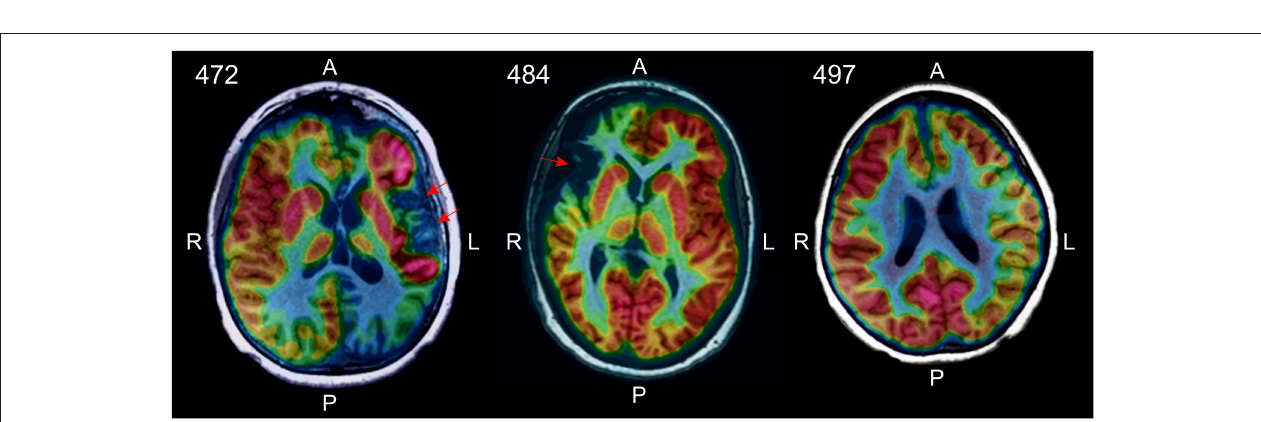
FIGURE 7 | [ 18 F]-deoxyglucose positron emission tomography (FDG-PET) identified areas of atrophy in RE cases 472 and 484 (red arrows). In RE case 497 there were no obvious signs of atrophy in the affected hemisphere, rather decreased glucose metabolism over the entire hemisphere was apparent.